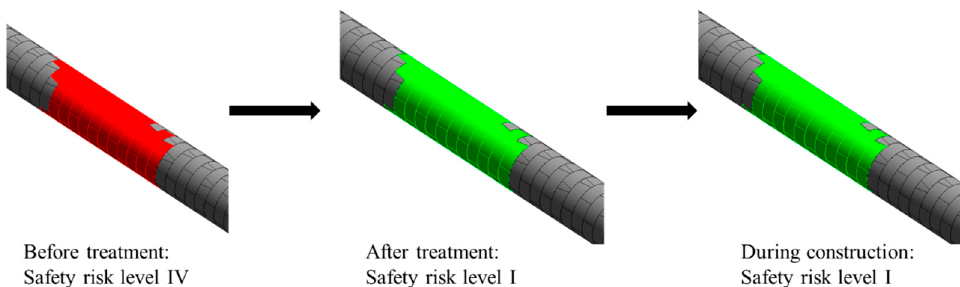
Figure 15. Safety risk levels visualization in BIM model.